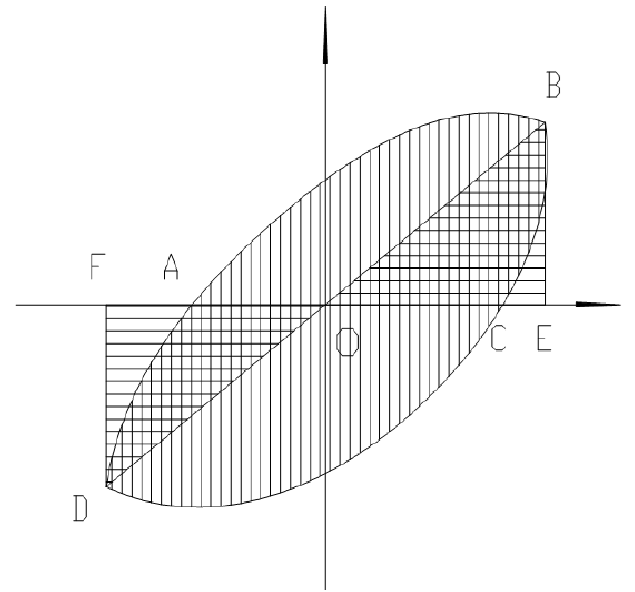
Figure 12. Calculation chart for effective energy and damping